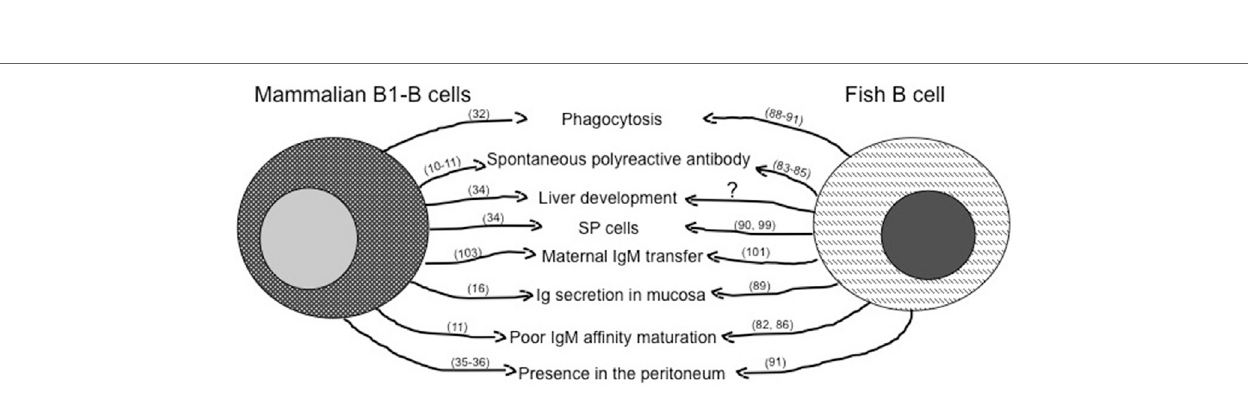
FigURe 2 | Similarities between mammalian innate-like B lymphocytes and fish B cells. The figure reassumes similar immune activities of B1-B cells as they are known in mammals and in fish. The question mark represents activities likely present, but not fully demonstrated yet. Main references for the indicated activities are reported in brackets.